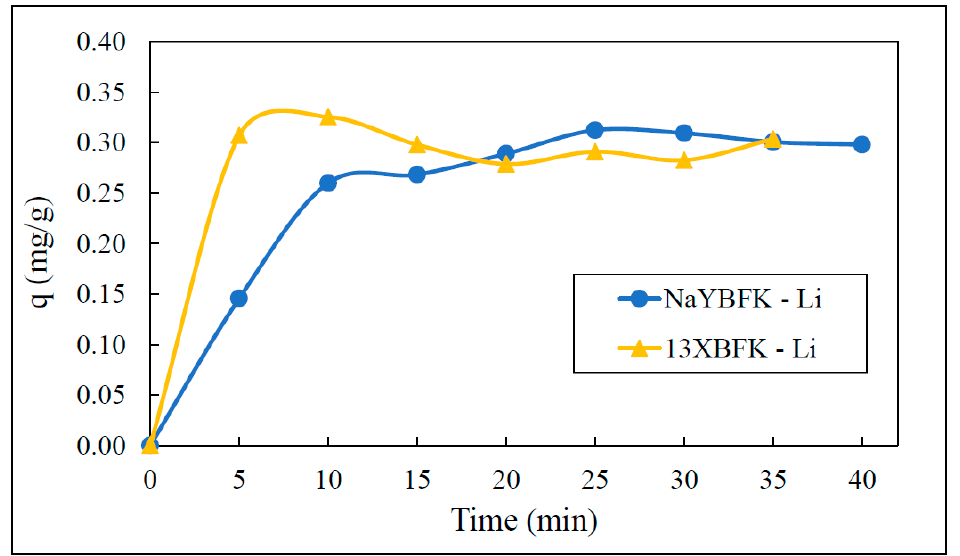
Figure 5. Li + adsorption at 298 K. Conditions: 5 g/L of adsorbent dosage, 1100 rpm, and 20 mg/L of initial Li + concentration.